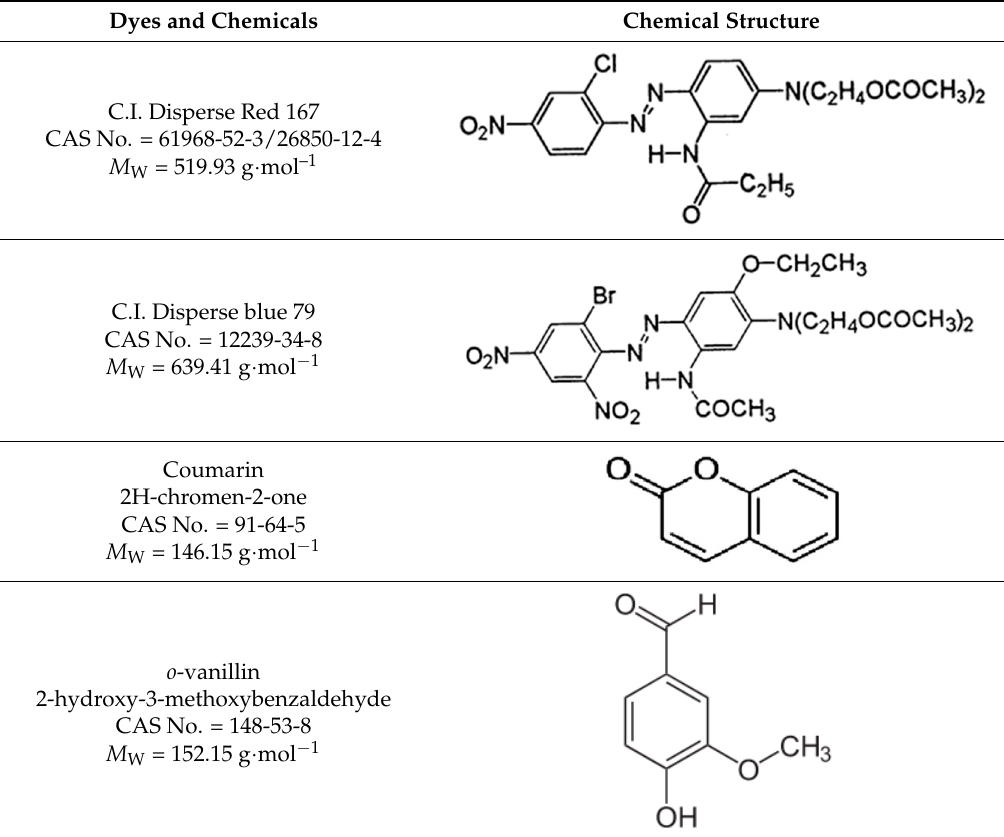
Table 1. Chemical structure of dyes and auxiliaries.